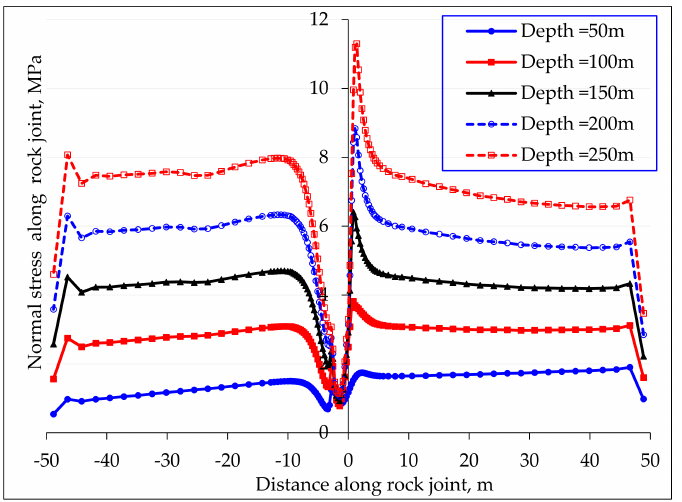
Figure 23. Normal stress along a rock yielded joint that passes below the tunnel opening at various tunnel depths below surface.